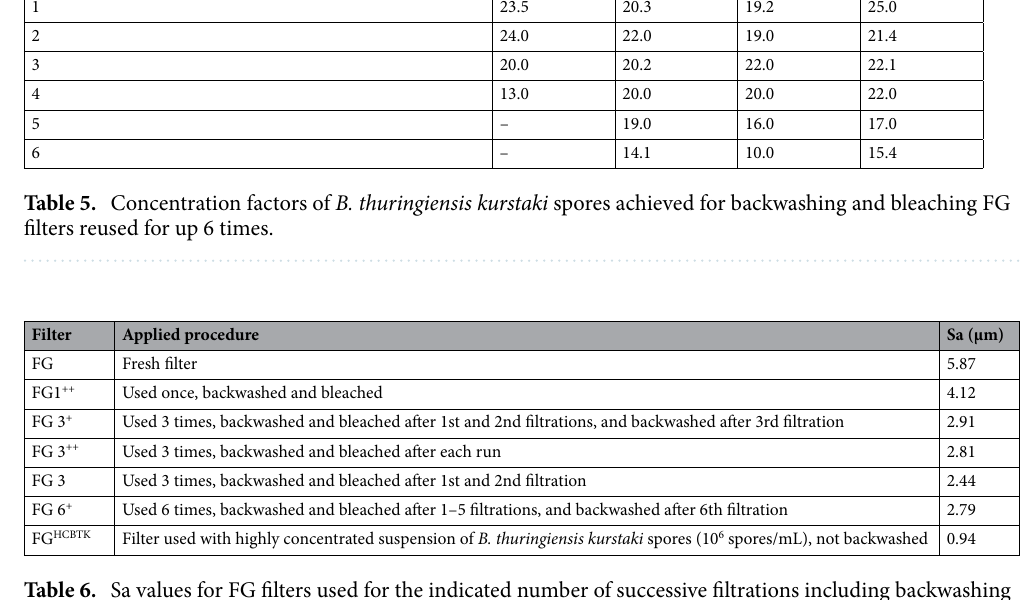
Table 6. Sa values for FG filters used for the indicated number of successive filtrations including backwashing and bleaching. The (+) and (++) indicate if either backwashing only, or backwashing and bleaching were applied, respectively, as the last steps before collecting confocal images. HCBTK means “highly concentrated suspension of B. thuringiensis kurstaki